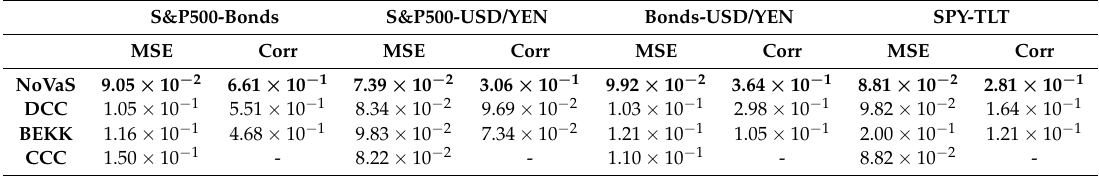
Table 8. Mean-Squared-Error and correlation between realized correlation and captured correlation by the different methods. The NoVaS transformation used is the one that performed best in Table